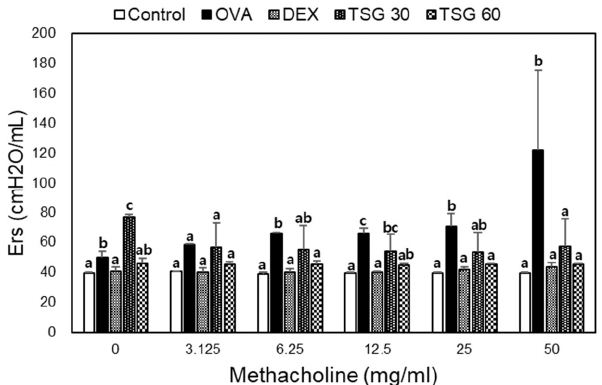
Figure 1. Assessment of allergen-induced airway hyperresponsiveness by the forced oscillation technique. Elastance (Ers) was determined in OVA-sensitized mice challenged with OVA after IP infection of 2,3,5,4’-tetrahydroxystilbene-2-O-β- D -glucoside (TSG) at two concentrations (groups TSG30 and TSG50), dexamethasone (DEX), or saline (OVA); control mice were challenged with saline alone. a, b, and c: The means not sharing a common letter are significantly different between groups at p < 0.05 as measured by one-way ANOVA with Duncan’s multiple-range